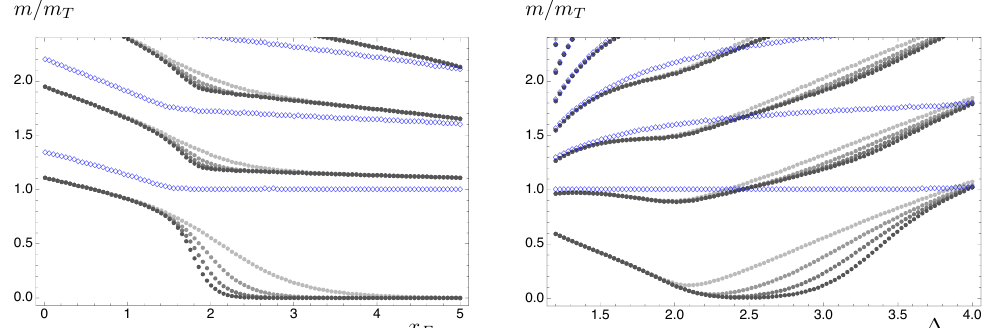
Figure 9 . Model I. Spectrum of S -resonances normalized to the mass m T of the lightest tensor, as a function of x with ∆ = 3 (left panel) and as a function of ∆ with x F panels have ρ = 10 . The result of using the scalar-potential invariant I 2 for different values of the IR cutoff ρ = − 13 , − 10 , − 7 , − 4 (darker to lighter), whereas the result of 1 using the invariant I and ρ = − 13 is shown in blue diamonds. 2 1